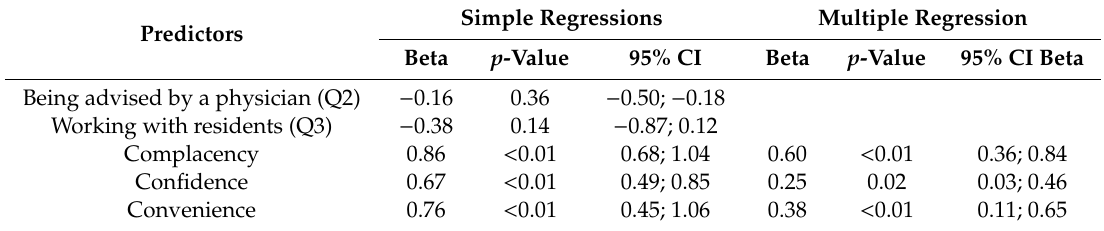
Table 3. Determinants of the attitudes towards vaccination. CI: confidence interval. Simple Regressions Multiple Regression Predictors Beta p -Value 95% CI Beta p -Value 95% CI